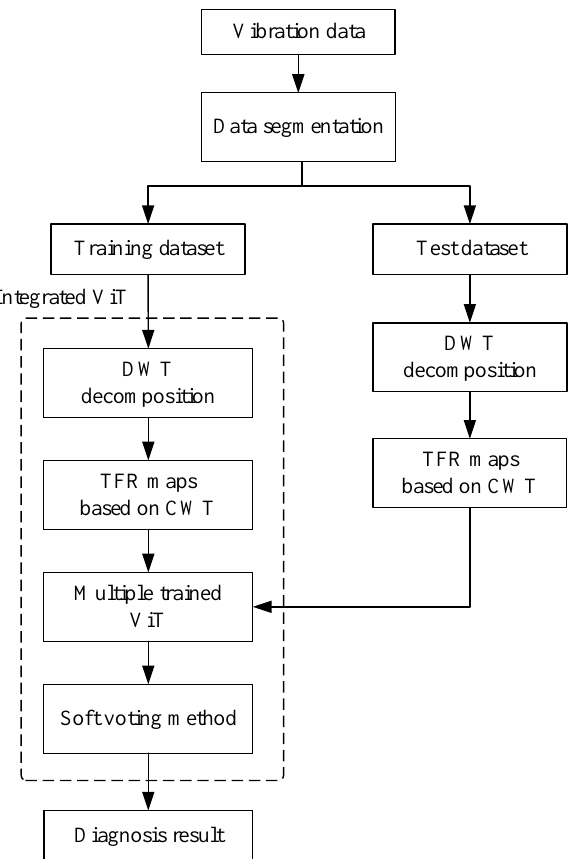
Figure 8. The diagnosis flowchart based on integrated ViT.